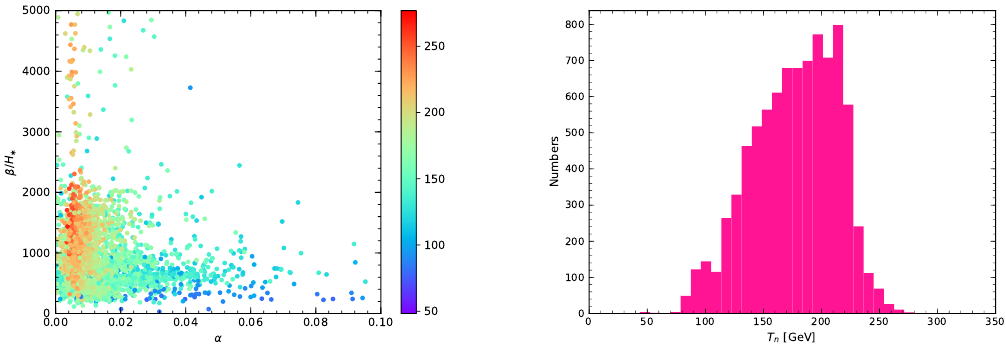
Figure 11 . Left plot: distributions of the GW parameters (cid:11) and (cid:12)=H (cid:3) . The colored bar indicates the nucleation temperature T n . Right plot: distribution of nucleation temperature T n